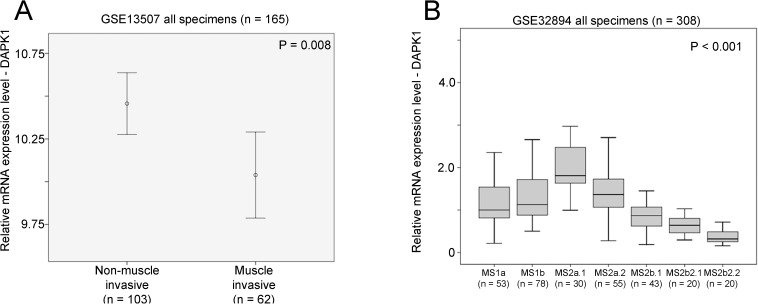
The association between mRNA expression of DAPK1 with muscle invasiveness and gene signature subtype.(A) An error bar plot for DAPK1 expression in non-muscle invasive and muscle invasive types of bladder cancer cohort GSE13507. (B) A box plot for DAPK1 expression in bladder cancer with different molecular subtypes